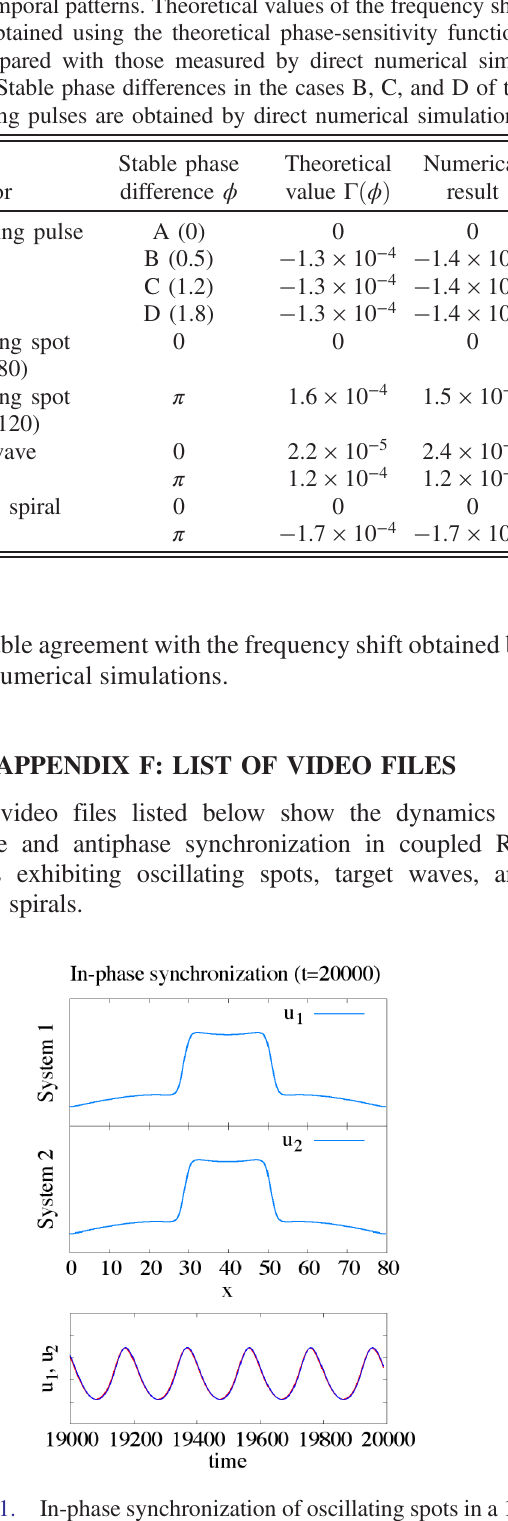
VIDEO 1. In-phase synchronization of oscillating spots in a 1D system of length L ¼ 80 . The parameters are the same as in Fig. 2. The initial phase difference is ϕ ð 0 Þ ¼ 0 . 616 . The bottom figure shows the evolution of the activator variables ð u 1 ; u 2 Þ at the center ( x ¼ L= 2 ) of both